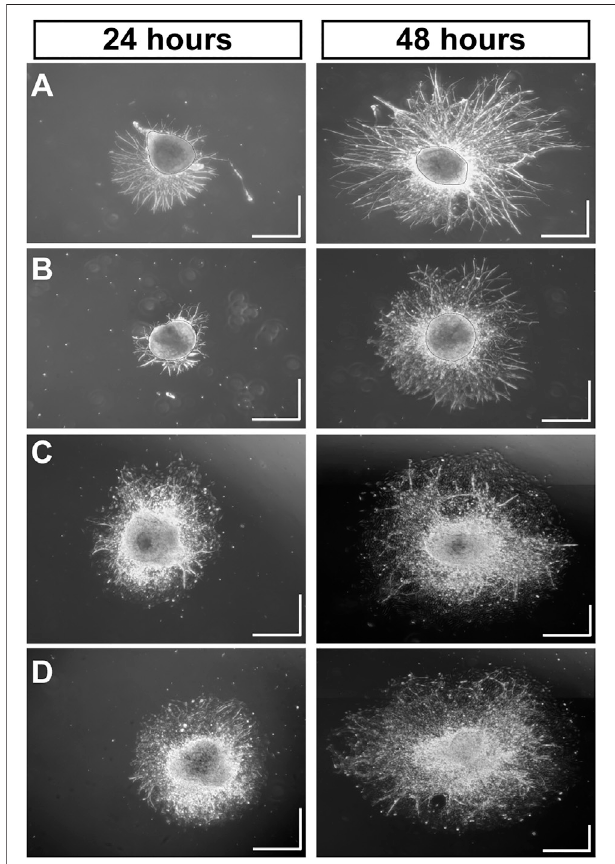
FIGURE 2 | Mimetic Peptides are Neurotrophic. Dorsal root ganglia (DRG) explants 24 and 48 h after plating on intact collagen (A) vs. partially digested collagen treated with vehicle (B) . Treatment with CMP 10A (C) and CMP09C (D) ,bothataconcentrationof100 μ M,increasesDRGneurite outgrowth and the area of the fi eld around the explant with neurite coverage compared to vehicle. Scale (cid:1) 0.5 mm in each direction.